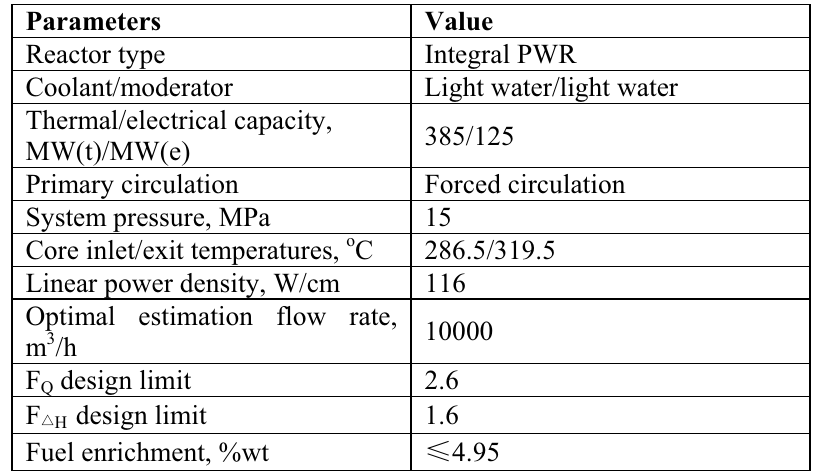
Table I.: Major (cid:3)(cid:3) Technical Parameters of